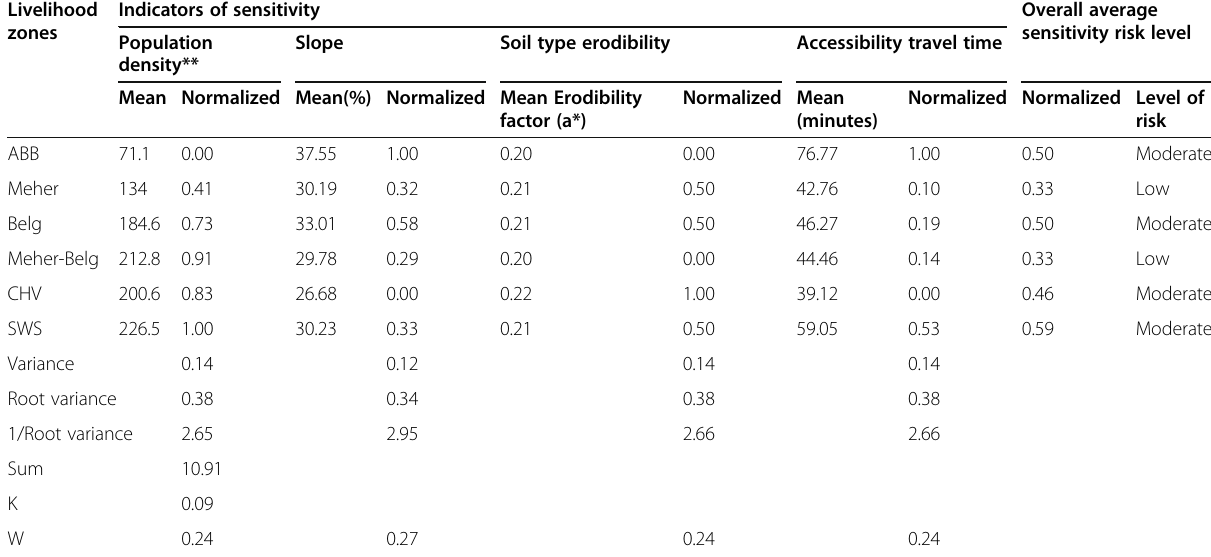
Table 5 Indicators of sensitivity and overall average sensitivity risk levels across the livelihood zones Livelihood